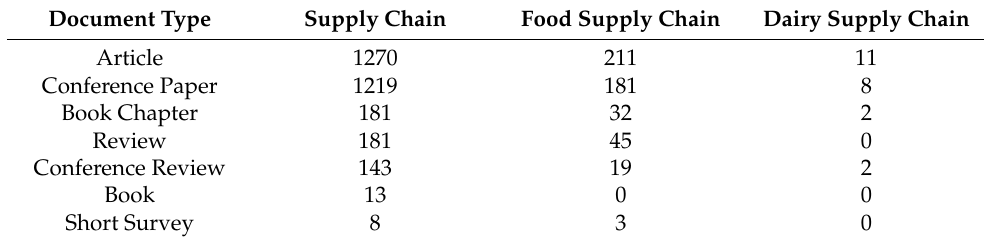
Table 3. Comparative analysis based on publication classification.